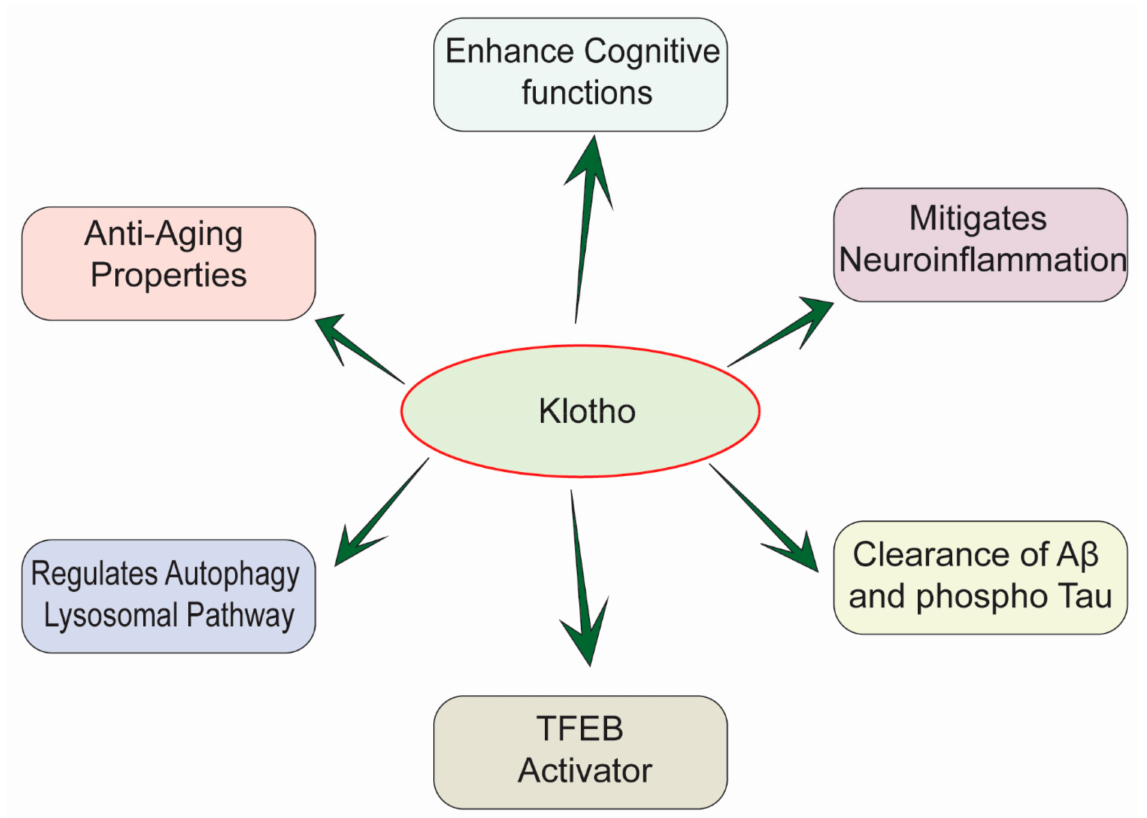
Figure 1. Multifactorial effects of Klotho in the pathology of